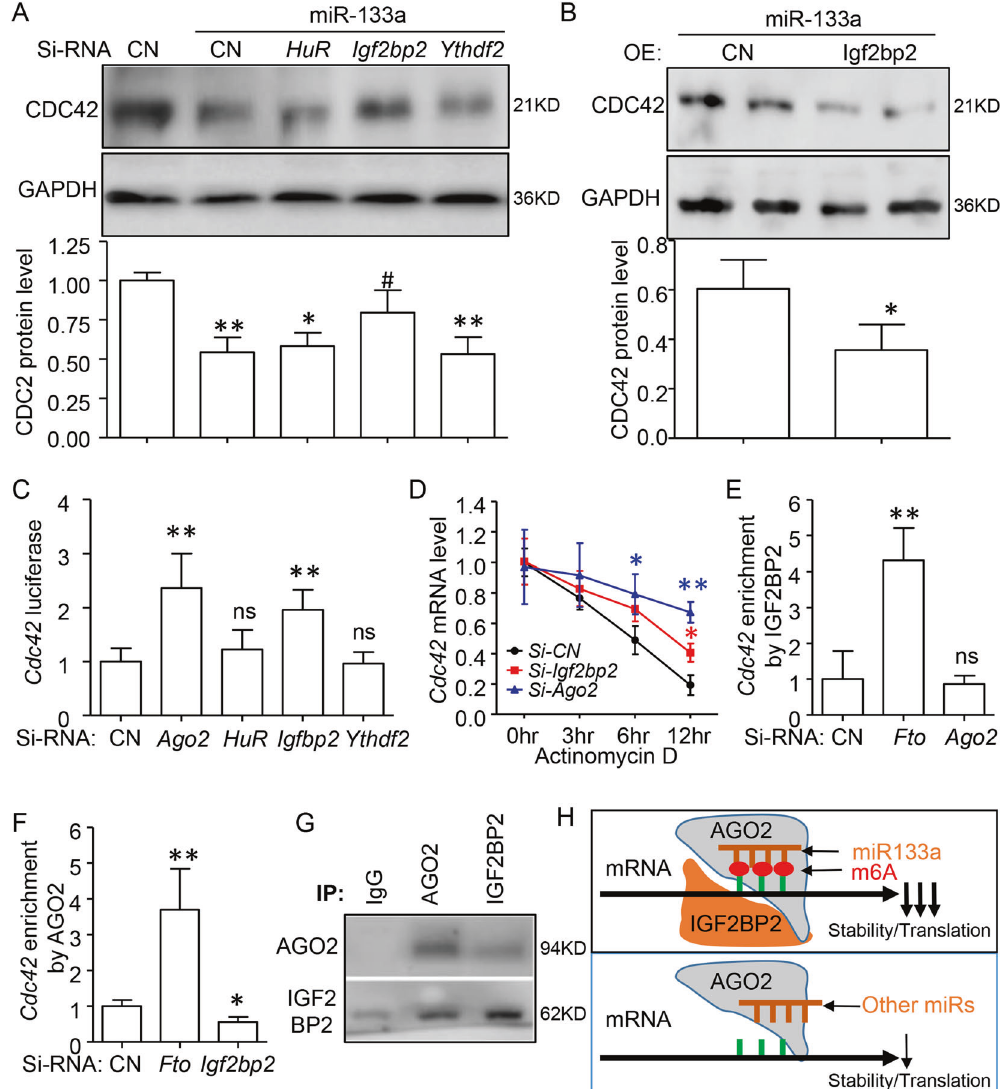
Fig. 5 m6A modi fi cation promotes the miR-133a repression on its targets via IGF2BP2. Neonatal mouse cardiomyocytes (CMs) were transfected with miR-133a and Si-RNAs. A Representative western blotting (up) and quanti fi cation (down) showing the miR-133a repression on CDC42 protein level could be reversed by Igf2bp2 , but neither HuR nor Ythdf2 knockdown in CMs. B Western blotting assay indicating overexpression of IGF2BP2 could further decrease CDC42 with miR-133a transfection. C Luciferase reporter activities were quantitated in CMs and indicated miR-133a activity could increase by knockdown of Ago2 or I gf2bp2 , but neither HuR nor Ythdf2 . D Inhibiting Cdc42 mRNA decay by silencing Ago2 or Igf2bp2 in Actinomycin D treated CM cells. E RNA immunoprecipitated-qRT-PCR assay using IGF2BP2 antibody suggested that the enrichment of IGF2BP2 on Cdc42 mRNA was increased by Fto knockdown, but had no effect by Ago2 silencing. F AGO2-RNA immunoprecipitated-qRT-PCR assay showing the enrichment of AGO2 on Cdc42 was increased by Fto knockdown but decreased by Igf2bp2 knockdown. G Co-immunoprecipitation and western blotting showing the interaction of AGO2 and IGF2BP2 in CMs cells, representative of three independent experiments. H Carton model of IGF2BP2 binding to m6A-modi fi ed site promotes the miR-133a-AGO2-RISC complex accumulation on its targets, which would enhance the decreasing of their stability and translation. Data are mean ± SD ( n = 4 per group). * p < 0.05; ** P < 0.01 was determined by one-way ANOVA followed by Tukey ’ s test in ( A , C , E , and F ). * p < 0.05 was detected by Student ’ s t test in ( B